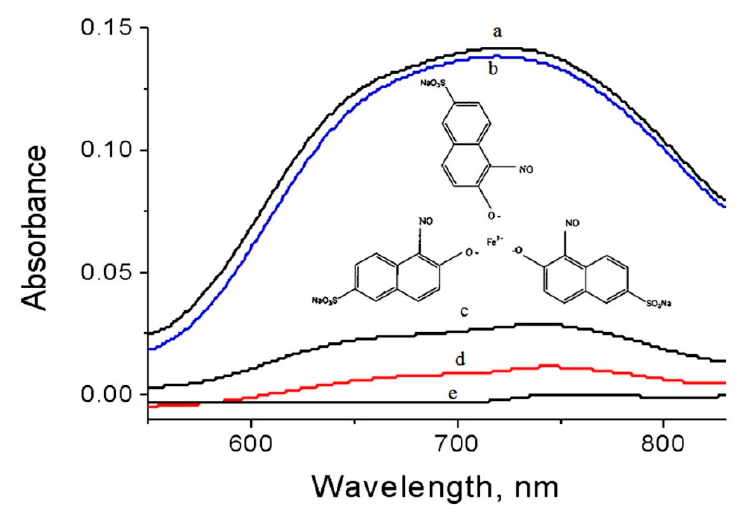
Figure 13. Absorbance spectra of naphthol green B after10 min in sunlight (a) No sample, and in presence of (b) alumina nanoparticles, (c) NC-1, (d) NC-2, and (e) NC-3.